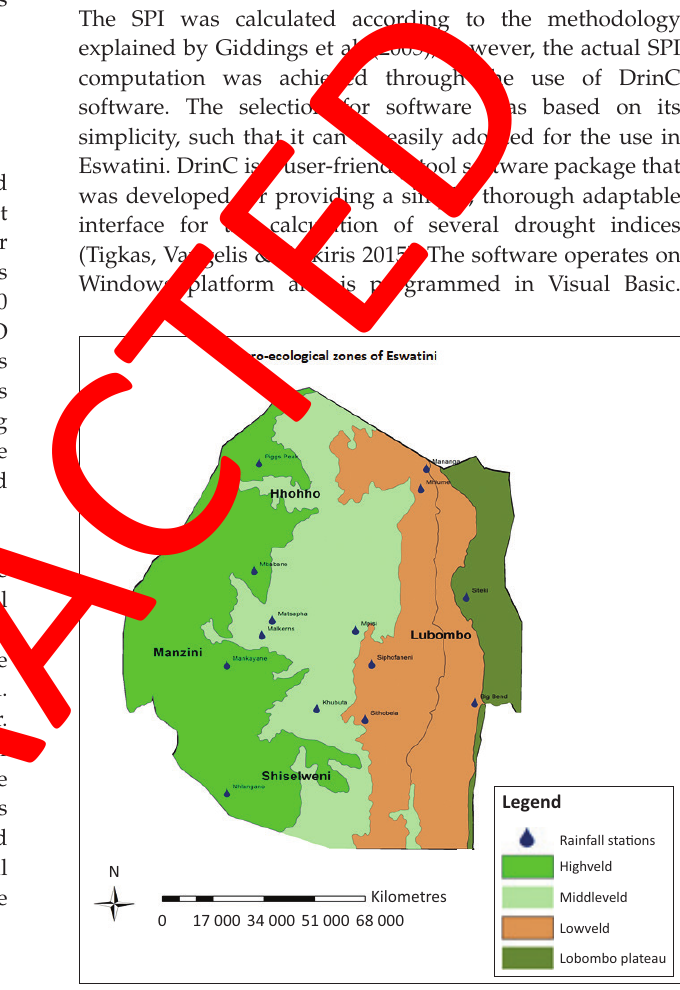
FIGURE 1: Map of Eswatini with agro-ecological zonation and the rainfall TABLE 3: Meteorological stations and their geographic coordinates.